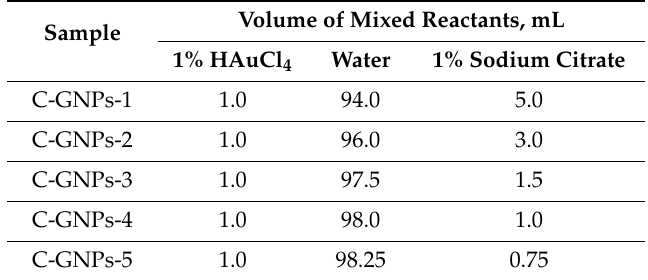
Table 1. Proportions of reagents for gold nanoparticles preparation using the Frens method. Sample